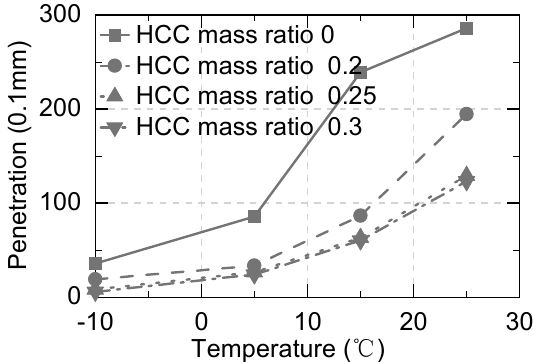
Figure 9. Penetrations of asphalt of different HCC mass ratios at different temperatures.